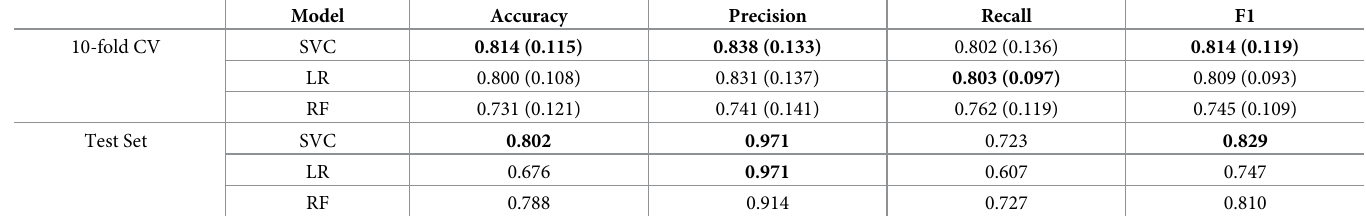
Table 4. Model performance for the 10-fold CV with standard deviation and the evaluation on test set using a combination of the GPT-3 Babbage embeddings and the acoustic